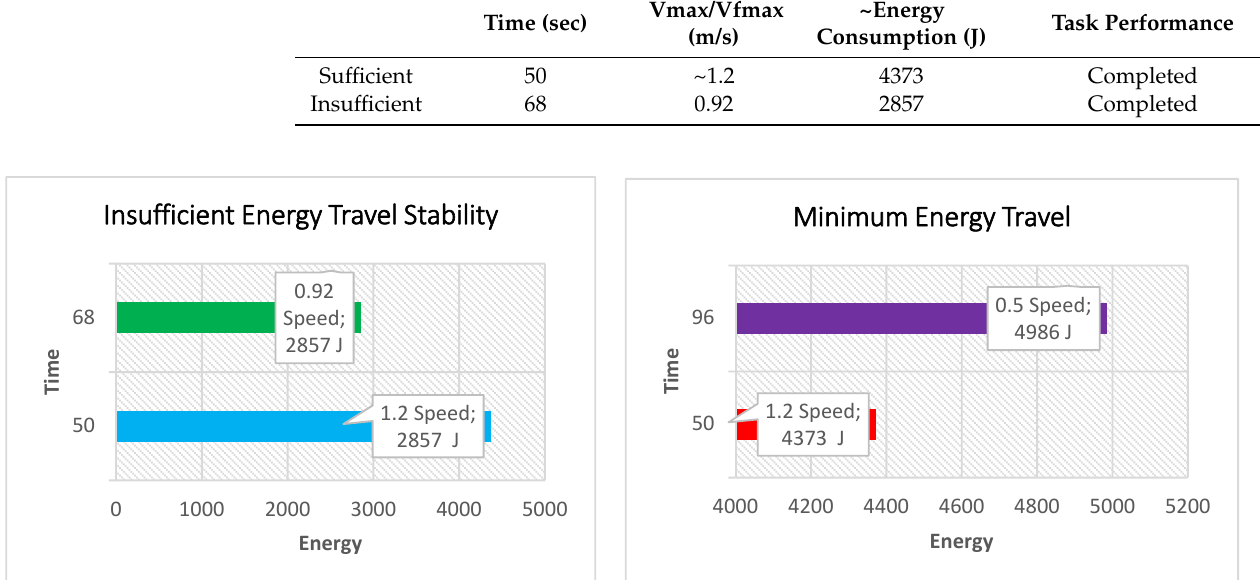
Figure 16. Travel energy consumption levels with little energy and minimal energy.